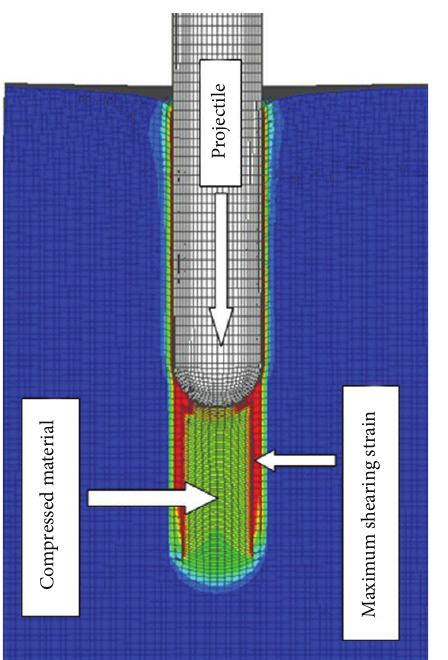
Figure 11: Foam failure process in numerical